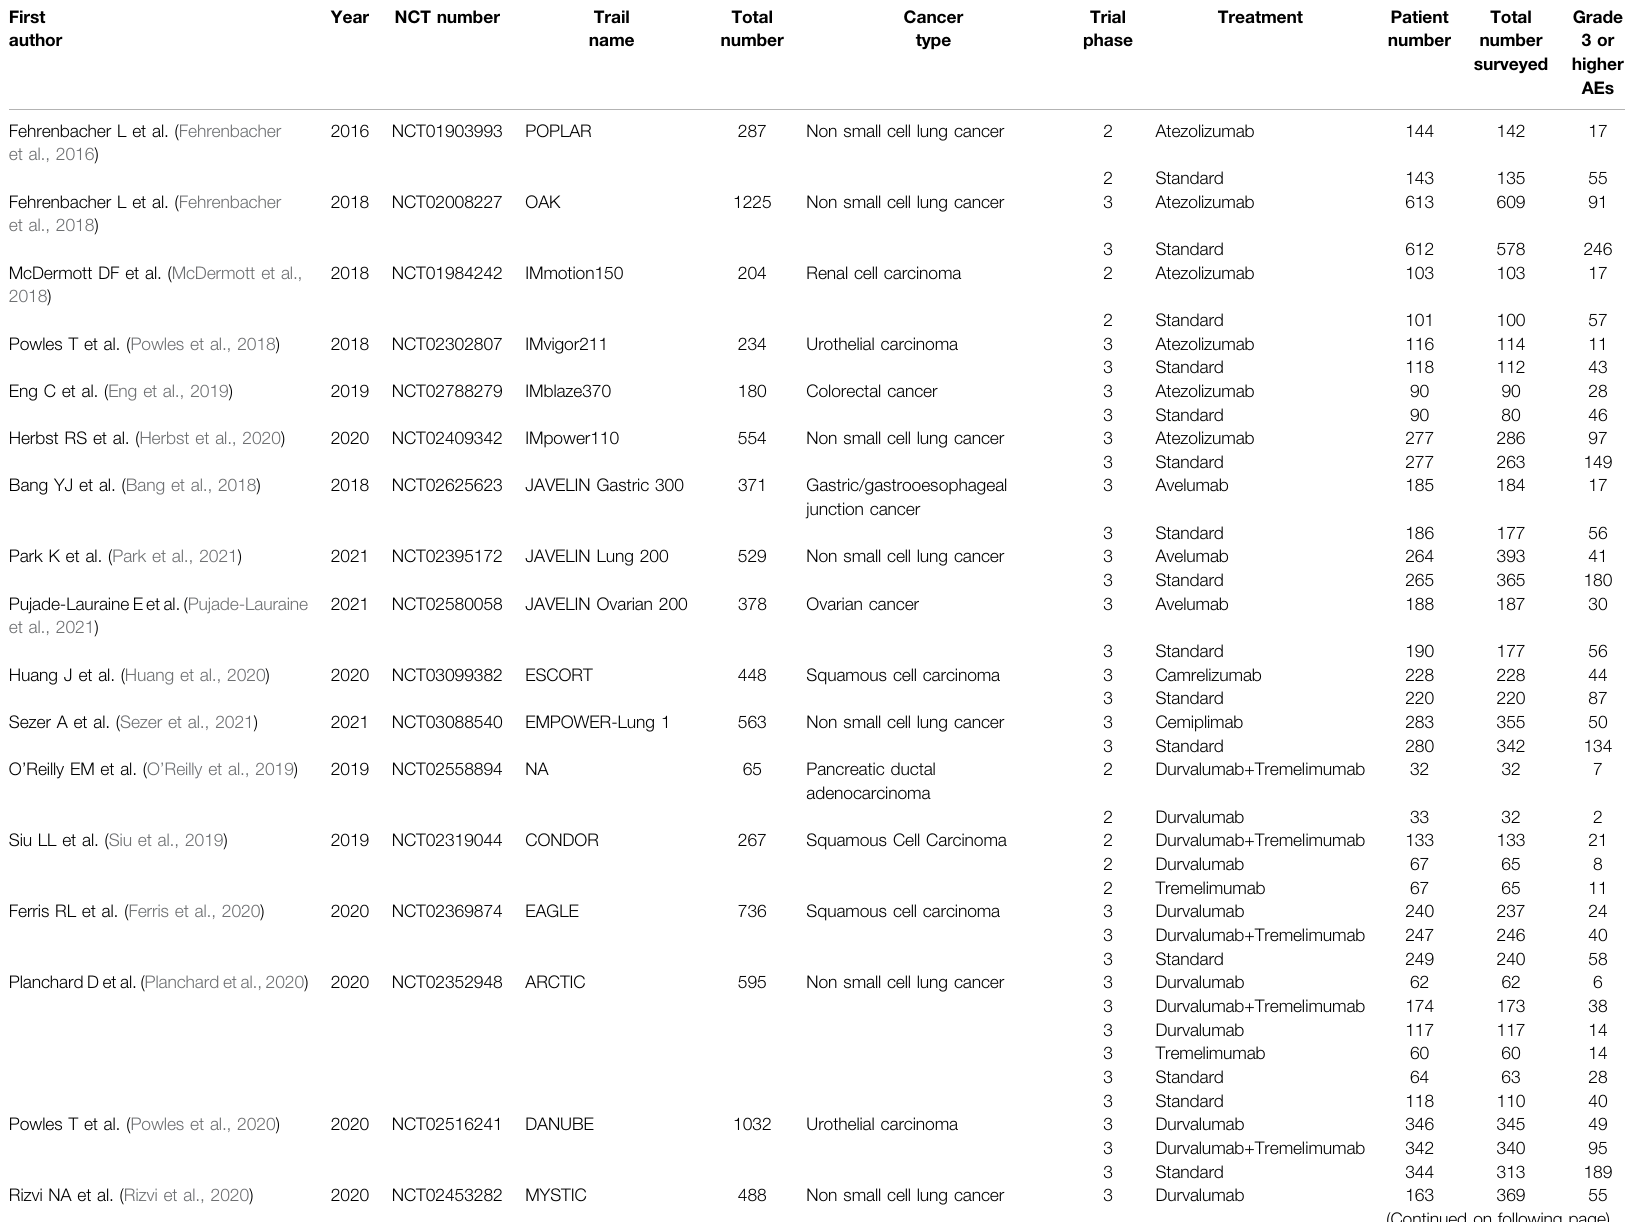
TABLE 3 | List of the studies involving serious AEs in this